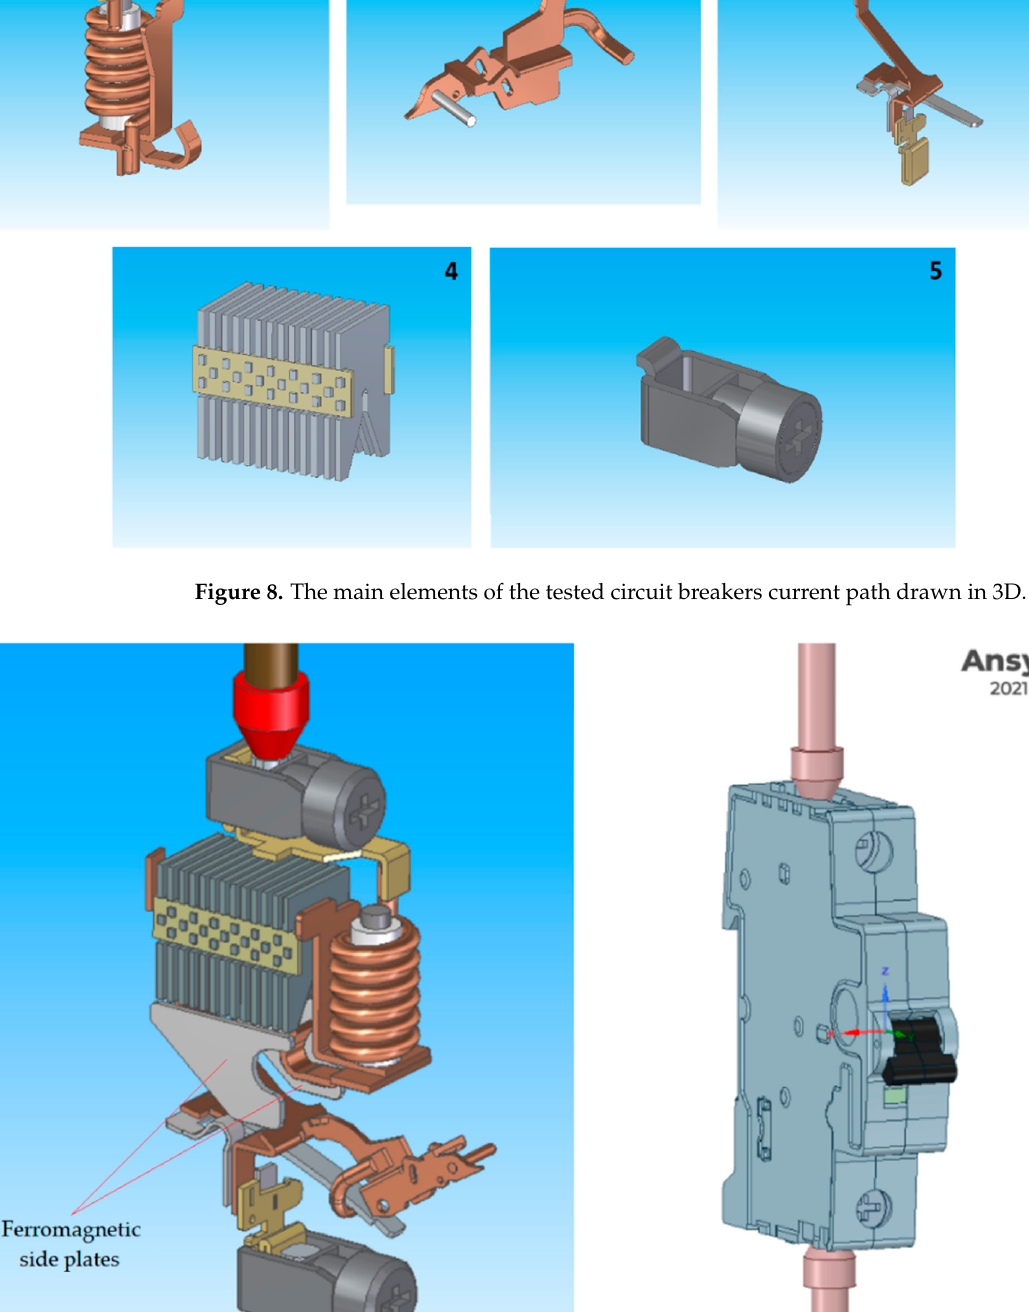
Figure 10. The distribution of electromagnetic induction density in the side ferromagnetic plates and in the plates of the extinguishing chamber at the moment of opening the contacts and the ap- pearance of an electric arc.